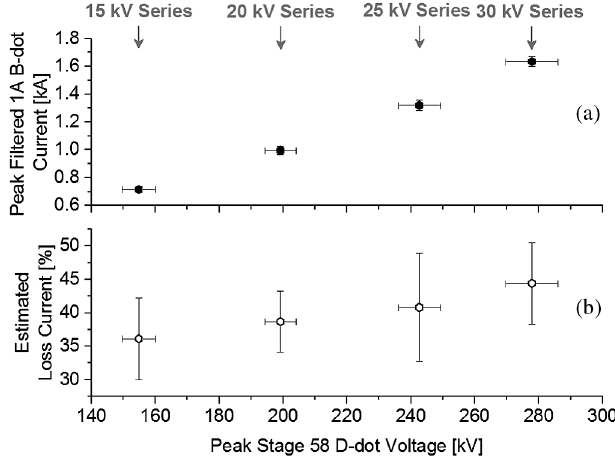
FIG. 12. Peak filtered 1A B-dot current (a) and estimated loss current (b) for the 15 – 30 kV experimental series as a function of peak Stage 58 D-dot